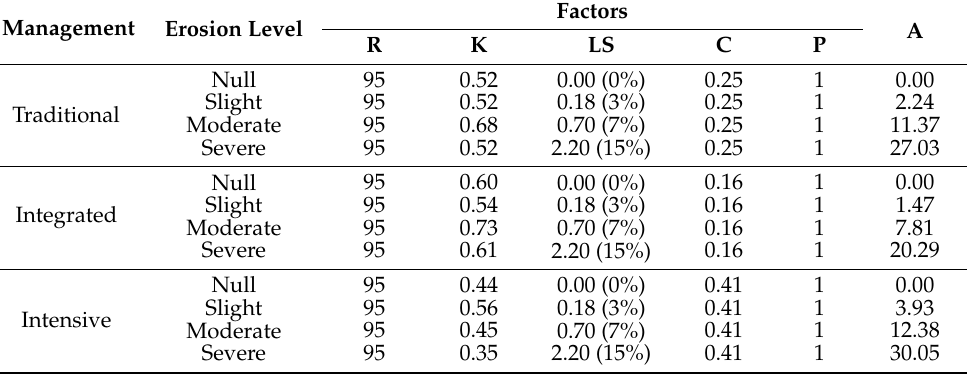
Table 1. Estimation of soil loss rates (A, in t ha − 1 year − 1 ), according the Universal Soil Loss Equation (USLE), where R: rain erosivity (J ha − 1 ); K: soil erodibility (Mg J − 1 ); LS: length and degree of slopes (dimensionless and in %); C: ground cover (dimensionless); and P: agricultural conservation practices (dimensionless). USLE has been calibrated for traditional, integrated, and intensive olive groves, considering all soil erosion levels, in the PDO Norte Alentejano.